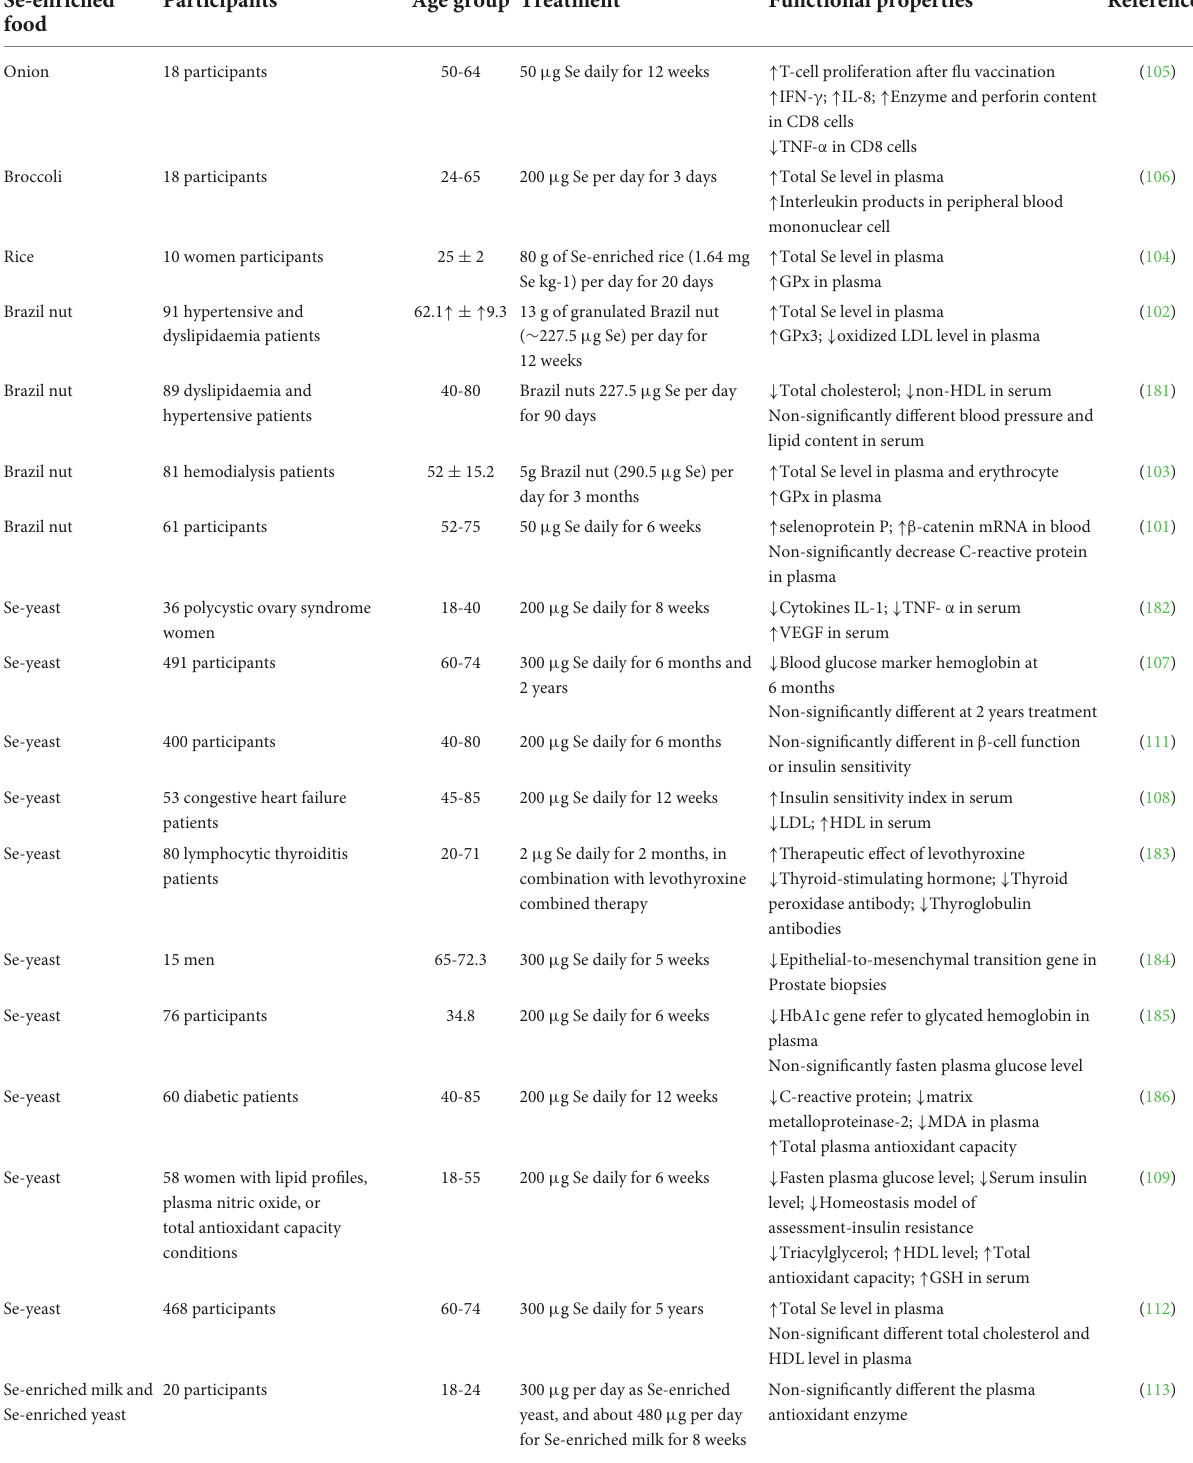
TABLE 4 Selenium-enriched plant foods and yeast human clinical